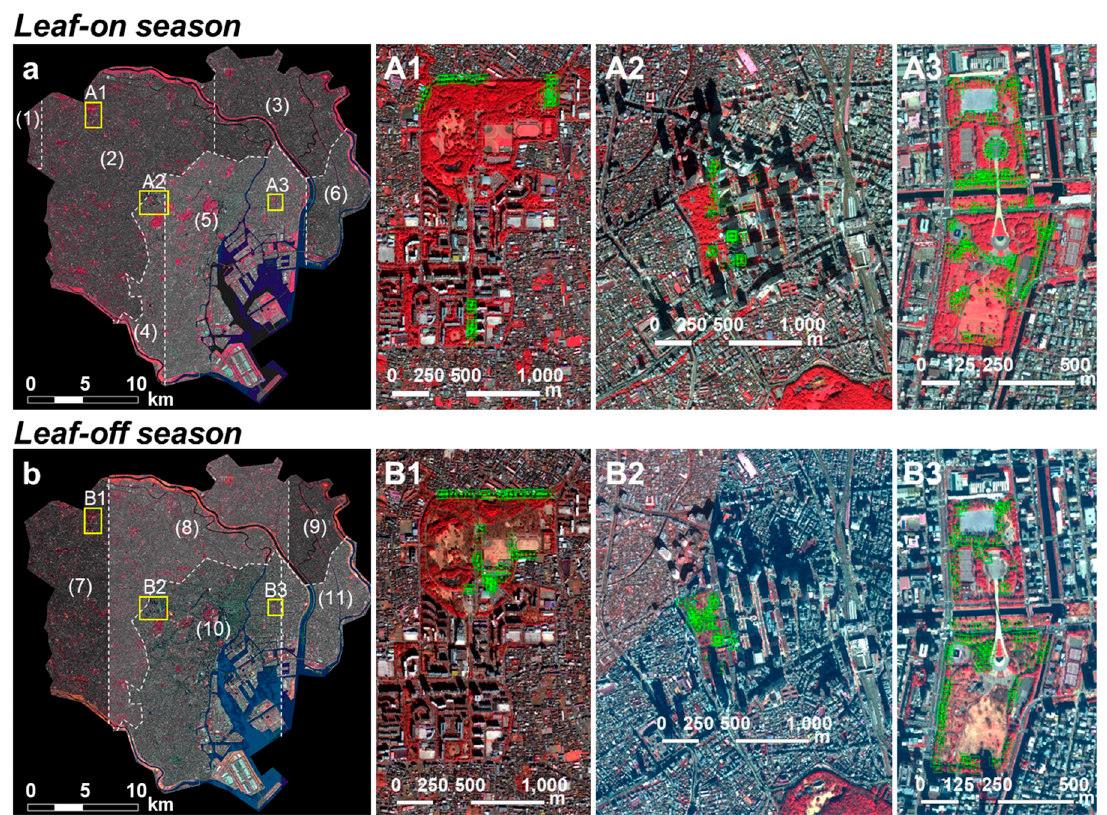
Figure 2. WorldView-2 / 3 imagery used in this study for (upper panels: ( a ) leaf-on season and (lower panels: ( b ) leaf-off season. The yellow areas in ( a ) and ( b ), respectively, represent the sites where leaf area index (LAI; m 2 m − 2 ) field measurement was conducted in each season ( A1 – A3 and B1 – B3 ). The green plots illustrate the LAI field measurement points. Aerial photograph inspection in ( A2 and B2 ) and field investigation in ( A3 and B3 ) were conducted to assess the accuracy of tree mapping results from WorldView-2 / 3 imagery. Satellite imagery from DigitalGlobe Products. ( a , A1 , b , and B1 – B3 ) WorldView2 © 2020 DigitalGlobe, Inc., a Maxar company. ( a , A2 , and B3 ) WorldView3 © 2020 DigitalGlobe, Inc., a Maxar company.